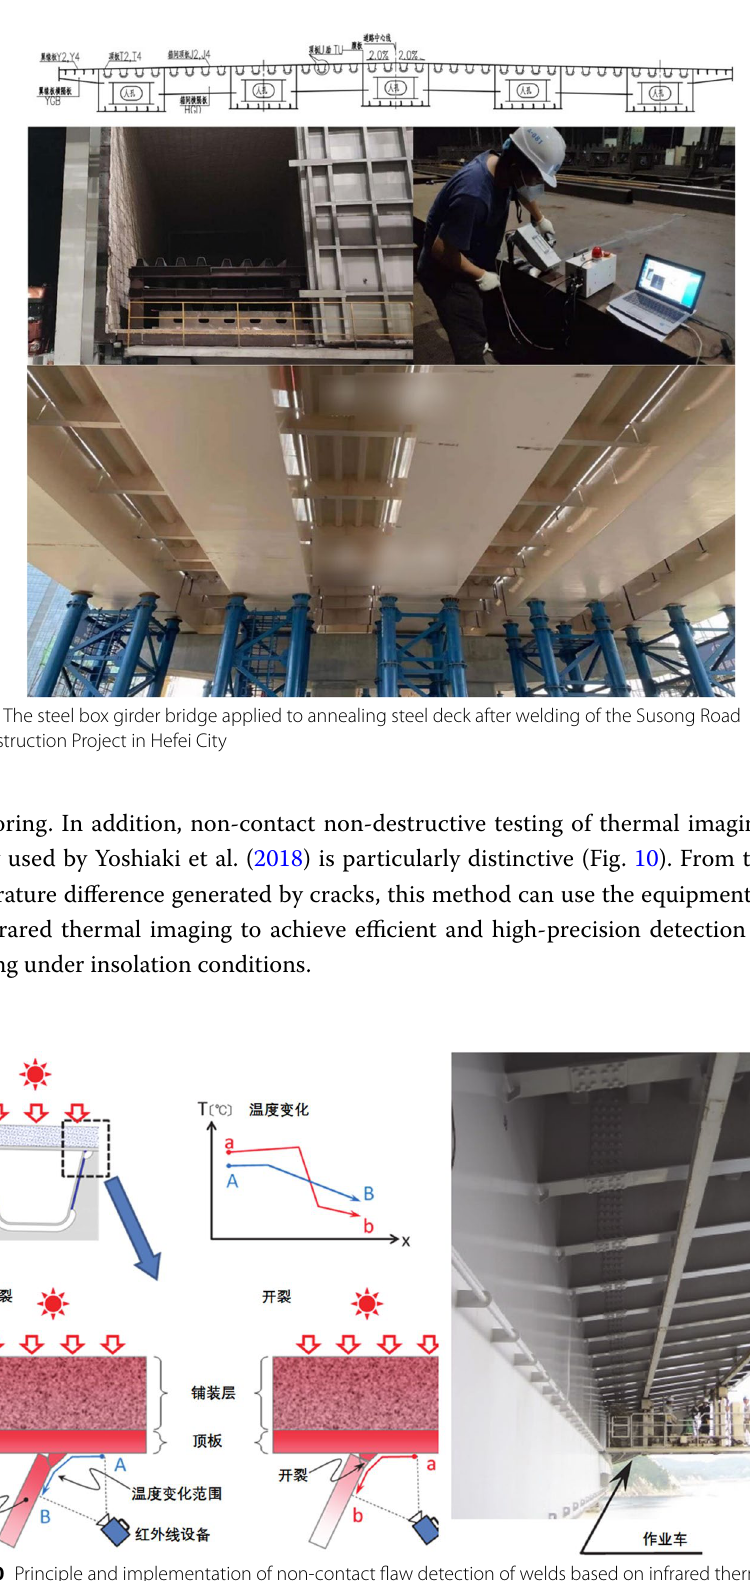
Fig. 10 Principle and implementation of non-contact flaw detection of welds based on infrared thermal